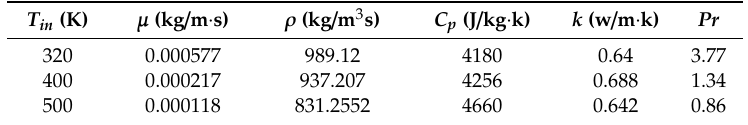
Table 2. Thermal properties of water at di ff erent inlet temperatures, Incropera [30]. Density, ρ , dynamic viscosity, µ , specific heat capacity, C p and thermal conductivity, k .